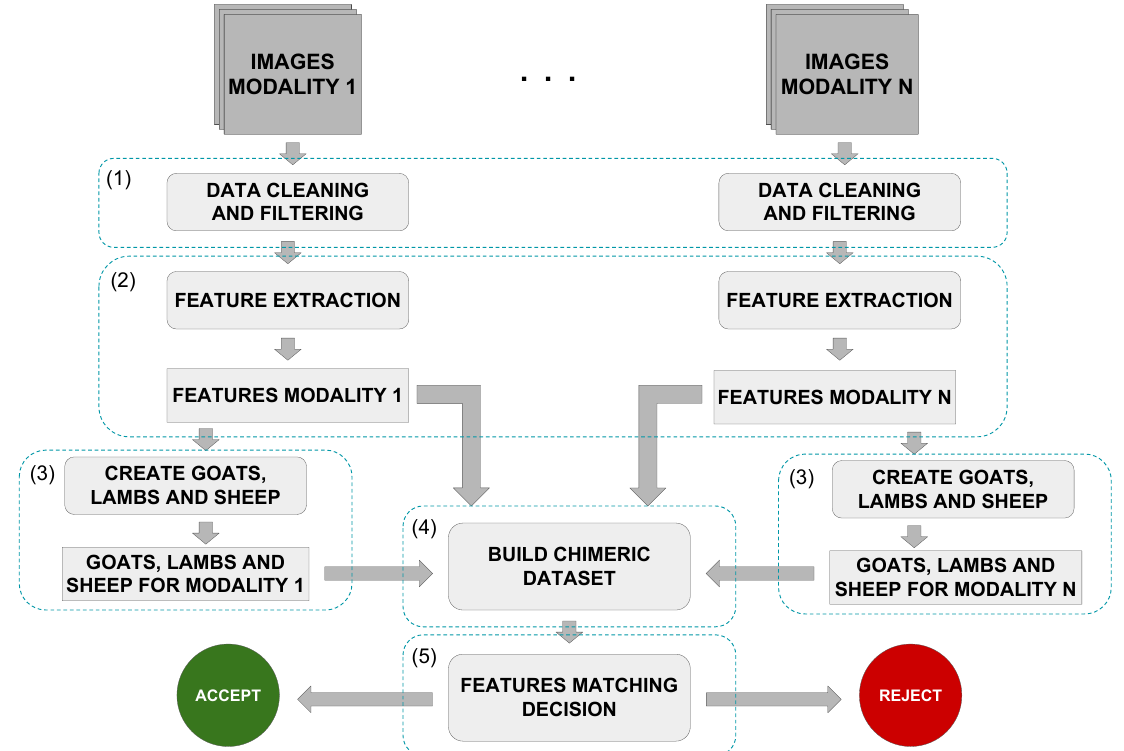
Figure 4. Recognition process of a chimeric